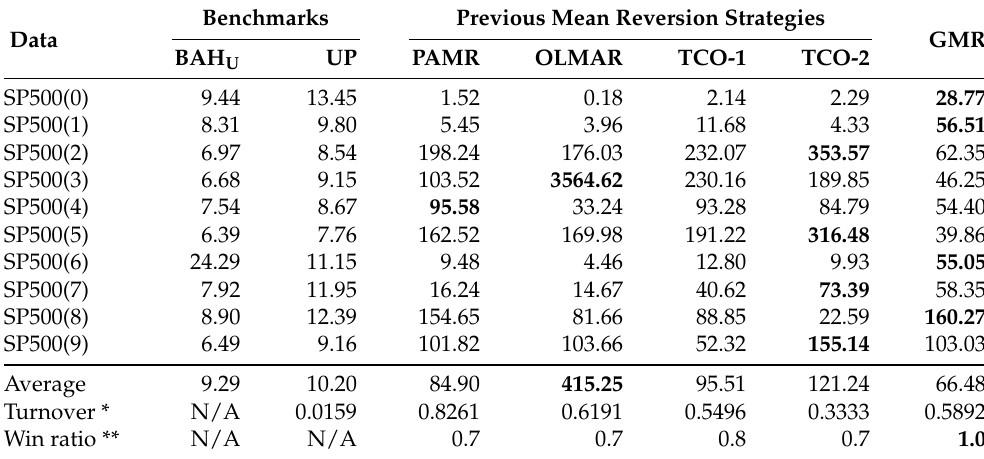
* Average daily turnover ratio. ** The odds of winning against both benchmarks. Although previous mean reversion strategies largely outperformed the